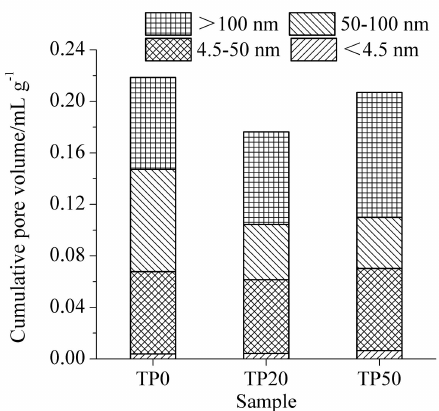
Figure 4. Pore structure of cement-ITP hardened paste cured for 3 days at 20 ◦ C.